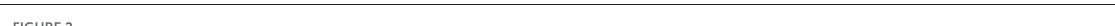
FIGURE2 Representative confocal images of the LC showing neurons expressing TH and puncta-expressing VGLUT1 in (C) Sham, (D) CCI7d, and (E) CCI28d rats (TH green; VGLUT1 magenta: scale bar, 20 µ m). (F–H) Quantification of the density of VGLUT1 + puncta in the (F) global, (G) dorsal, and (H) ventral LC. The data represent the mean ± SEM of the number of the puncta/ µ m 2 (obtained from three to four quadrants in a total of three LC sections per rat). The graphs depict (I) the frequency distribution of the TH + soma size and (J) the mean of soma size for each experimental group. The data are presented as the mean ± SEM of 30–35 random neurons per animal: * p < 0.05 vs. Sham, one-way ANOVA followed by a Tukey’s